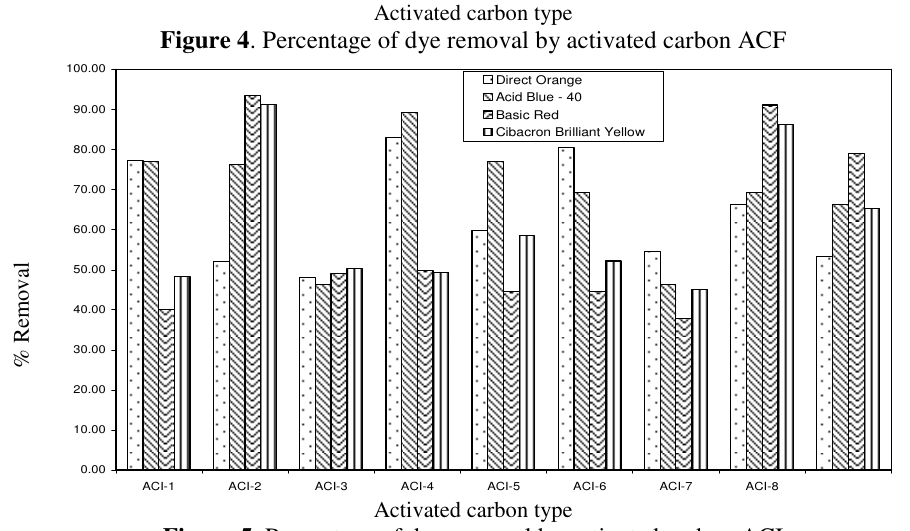
Figure 5 . Percentage of dye removal by activated carbon